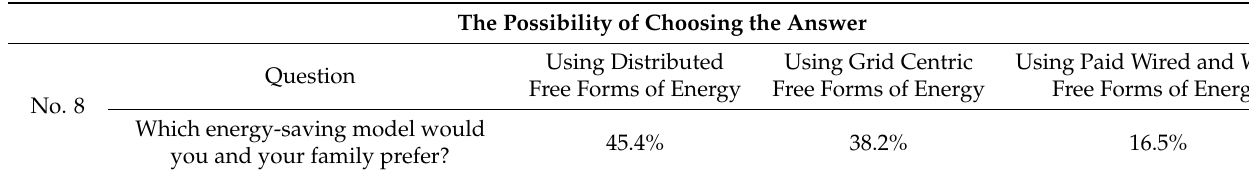
Table 9. Question no. 9, research results.